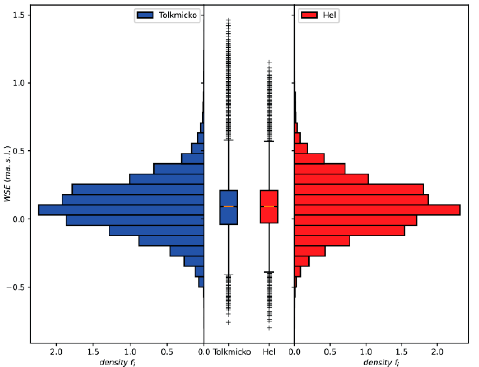
Figure 4. WSE (raw data) comparison at Tolkmicko (blue) and Hel (red) stations. Histograms and box plots. box